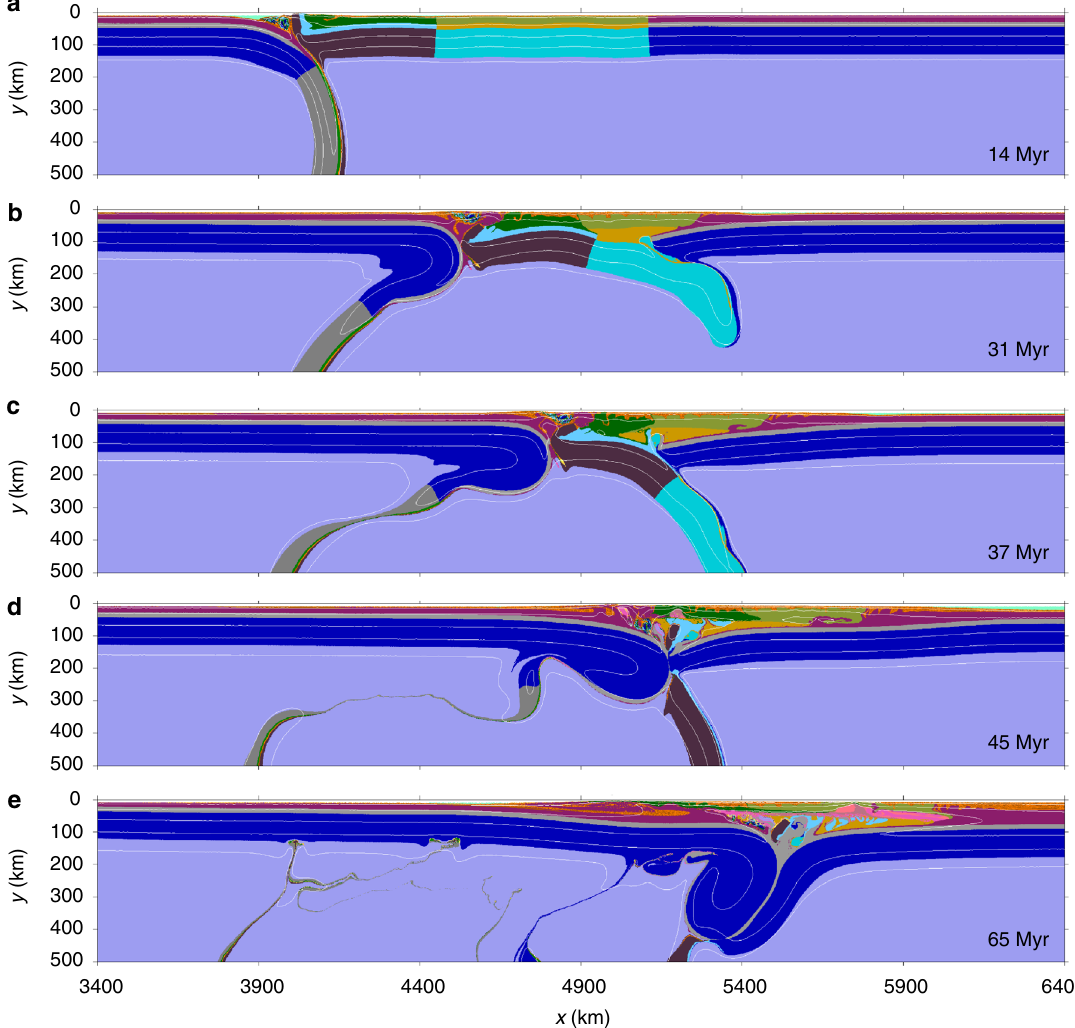
Fig. 3 Evolution of complete terrane detachment mode (Mode-I). The widths of the strong and weak terranes are 600 and 700 km, respectively. The reference density of the lithospheric mantle of both the strong and weak terranes is the same as the asthenosphere. Time of convergence is shown in each panel. Colors of rock types are as in Fig. 2a. White numbered lines are isotherms plotted every 300 °C starting from 100